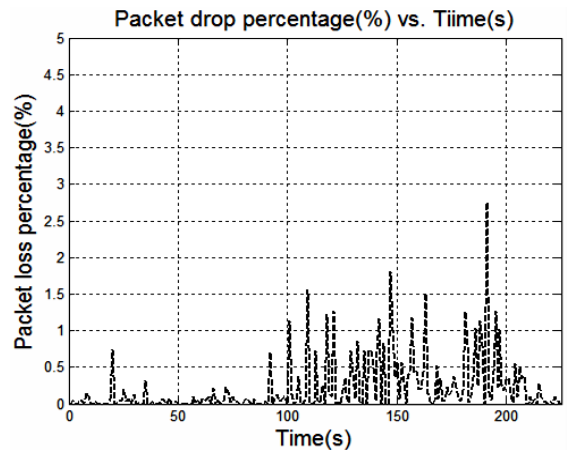
Figure 6. Packet loss percentage vs. Time.